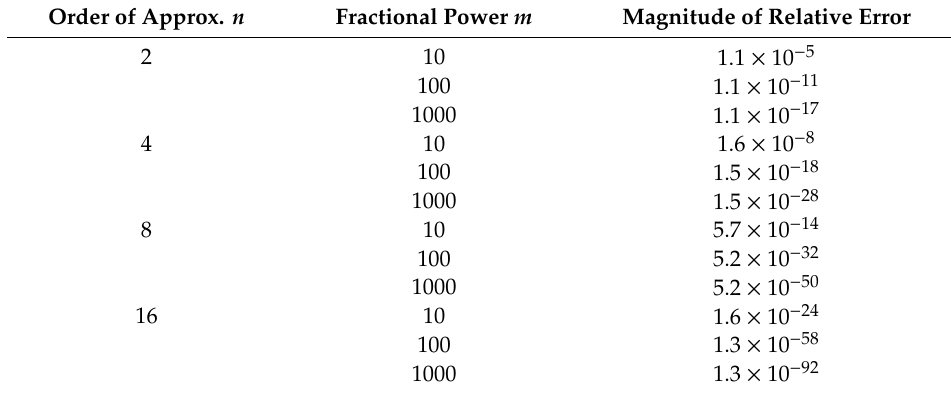
Table 6. Relative error in evaluation of ln( t ) for the case of t = 100. For the case of m = 1 the relative error is high for all orders of approximation. Order of Approx.